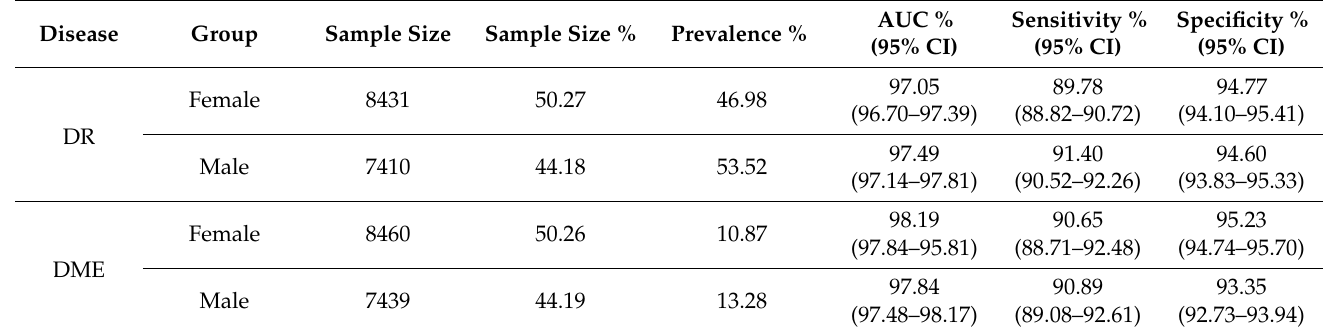
Table A3. Stratification results for the detection of referable retinopathy and diabetic macular edema on the patient level for sex.